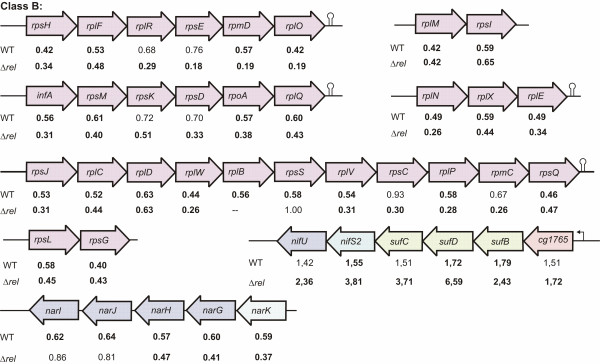
Illustration of putative operons of class B. For each experiment with the C. glutamicum RES 167 and its derived Δrel-mutant the induction or repression ratios are given. Bold numbers indicate a significant induction or repression of the corresponding gene according to the filtering criteria (5% error probability) applied on the microarray data. Genes are not drawn to scale. Known transcription start points are marked by small arrows. Predicted rho-independent terminators are indicted by hairpins.